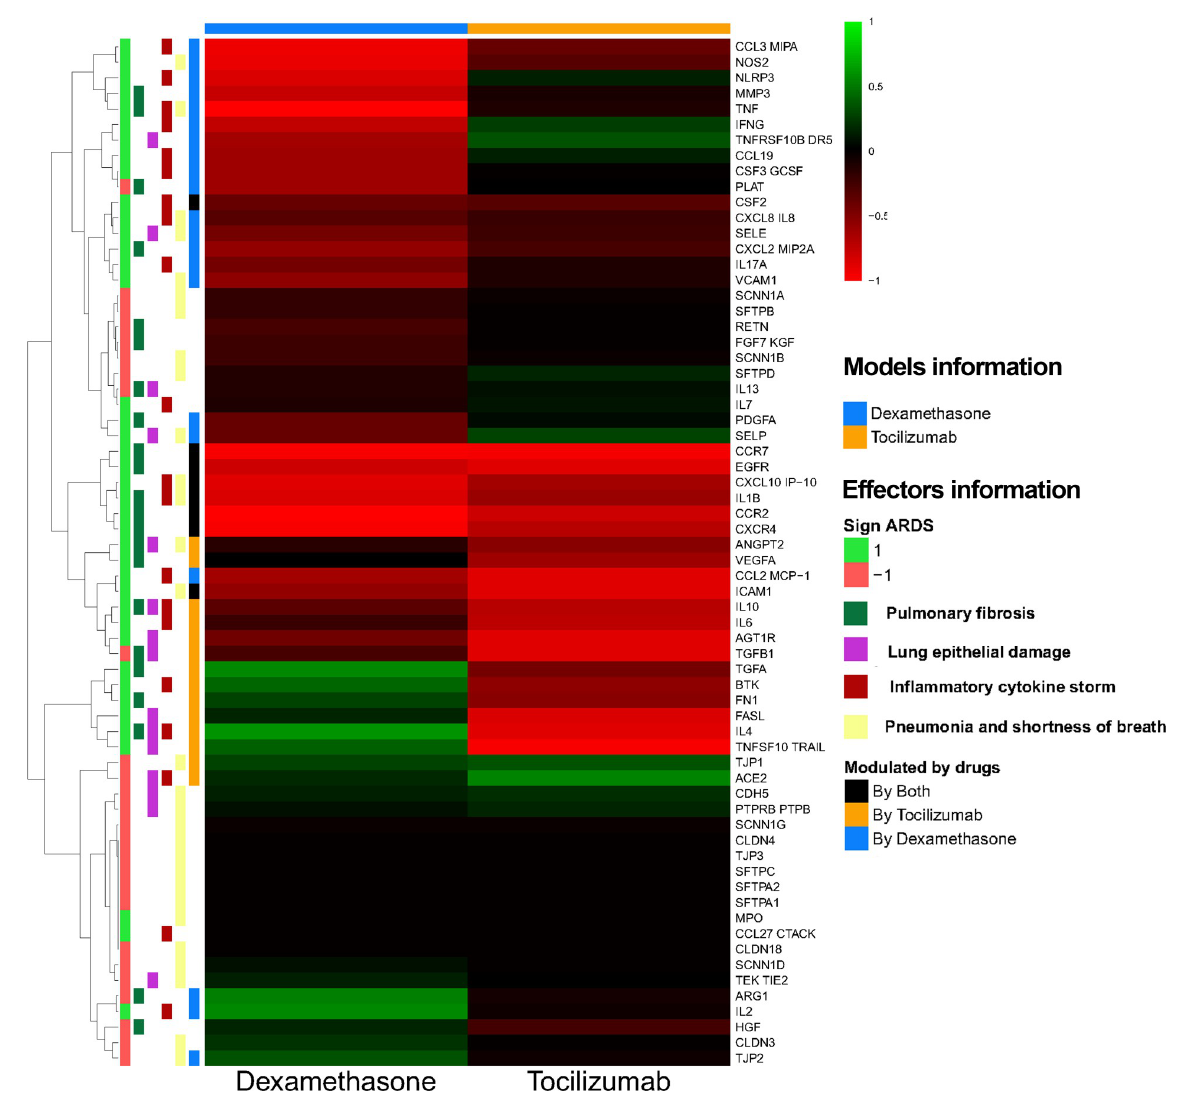
Fig 7. Effector protein heatmap activated for each model (dexamethasone and tocilizumab). Heatmap of the average predicted protein activity induced by dexamethasone and tocilizumab over the effectors of the pathology. The vertical bars indicate the pathological effect of the effectors ( ARDS sign : 1 if activated in the pathology, -1 if inhibited in the pathology); which COVID-19 evoked ARDS motives the proteins are assigned ( Effector in motive ) and whether the models reflect an effect of each drug over each effector ( Modulated by drugs , considering |0.3| as the threshold of modulation and of modulation difference between